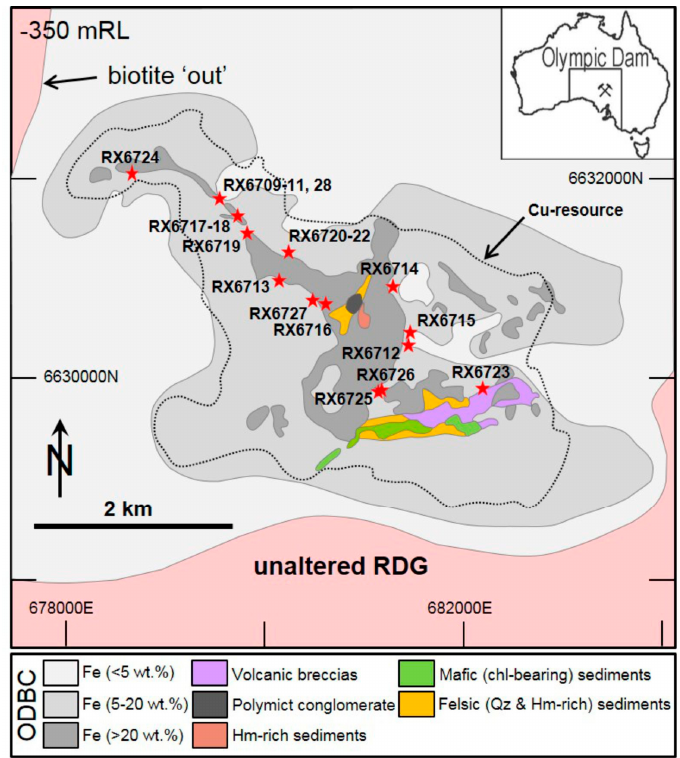
Figure 1. Sketch map of Olympic Dam orebody ( − 350 mRL) showing sample locations.